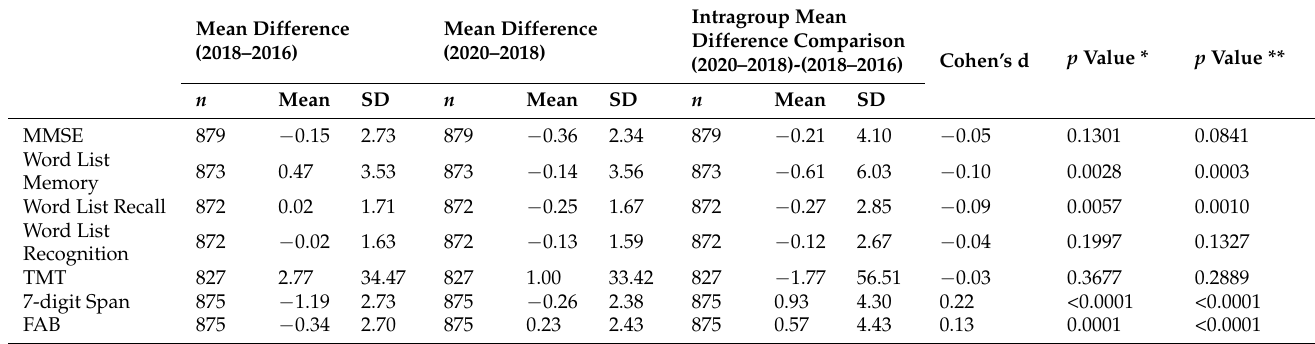
Table 4. Mean differences of cognitive function according to intragroup